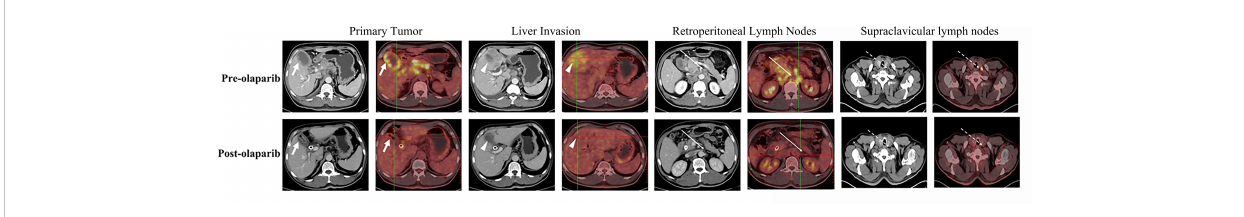
FIGURE 1 Representative pre- (upper row) and post-olaparib (lower row) treatment showing radiologic evidence in a 52-year-old man with gallbladder cancer harboring BRCA1 mutation. After 2 months of olaparib treatment, extensive metastatic lesions that involved the primary tumor (white arrow) and liver invasion (white arrowheads) became markedly reduced, while the retroperitoneal lymph nodes (long white arrows) and left supraclavicular lymph nodes (long white dotted arrows) disappeared when compared with those in the pre-olaparib treatment CT and PET/CT